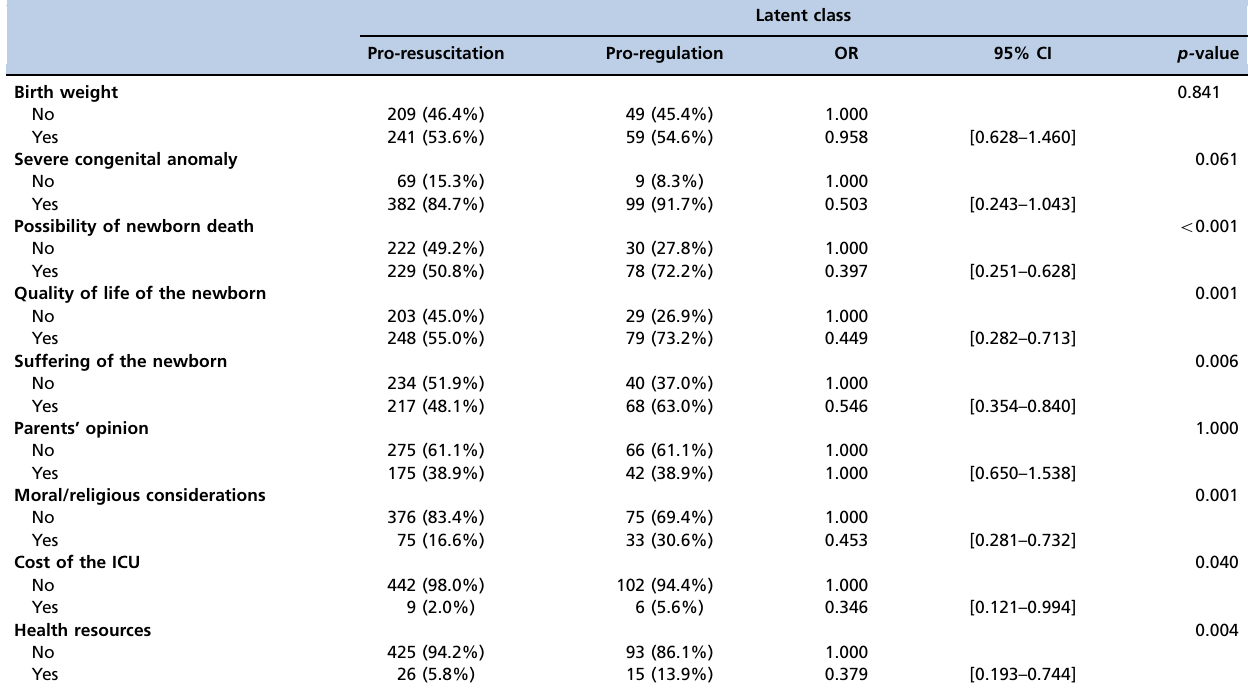
Table 4 - Criteria the respondents considered in the decision to initiate positive pressure ventilation according to the latent classes ‘ pro-resuscitation ’ or ‘ pro-regulation ’